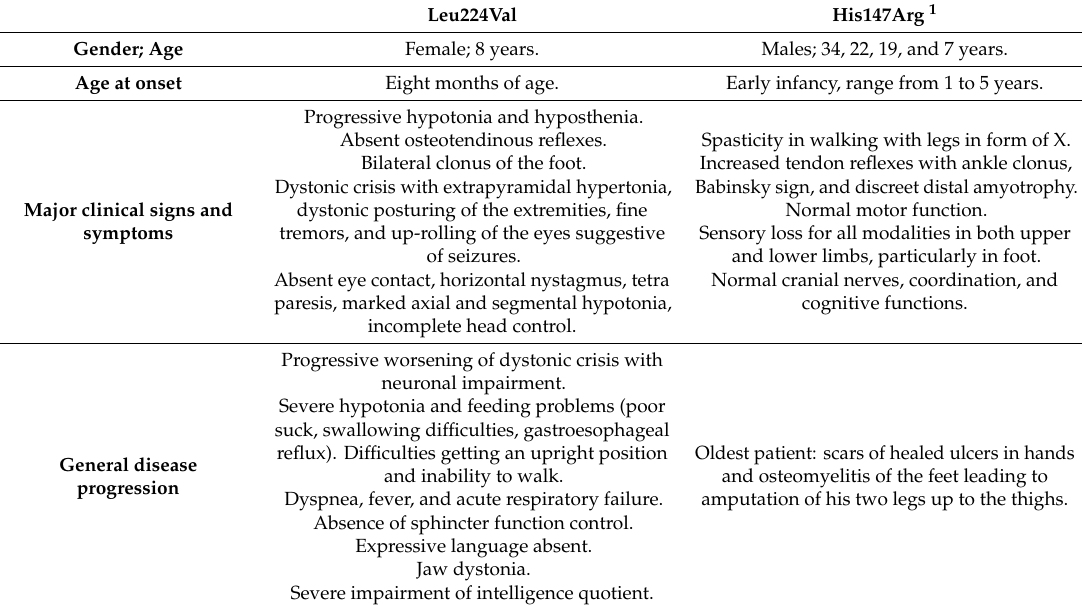
Figure 2. Proband at seven years of age showing microcephaly without evident dysmorphic features ( A , B ), tetra paresis and severe hypotonia ( C ). Table 1. Clinical data for CCT5 variants.